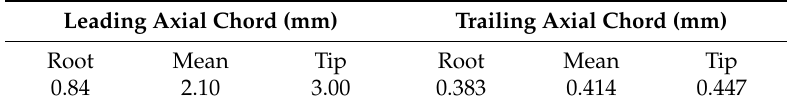
Table 10. Final parameters of the stator’s leading length and trailing edge blade profiles.